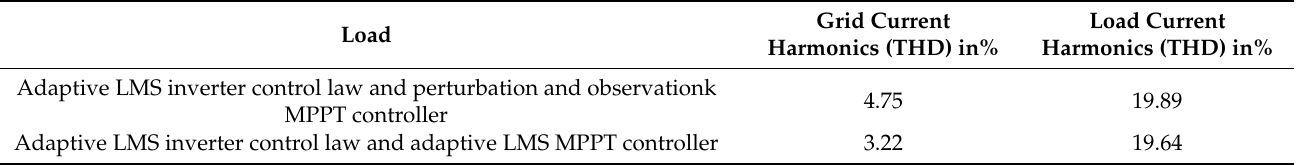
Table 6. Comparative analysis for two different combinations of MPPT and inverter controller non- linear load (10 kW linear connected in parallel with Rectifier with R = 10 kW and Q = 100 VAR) and variation in solar radiation 0 to 1000 W/m 2